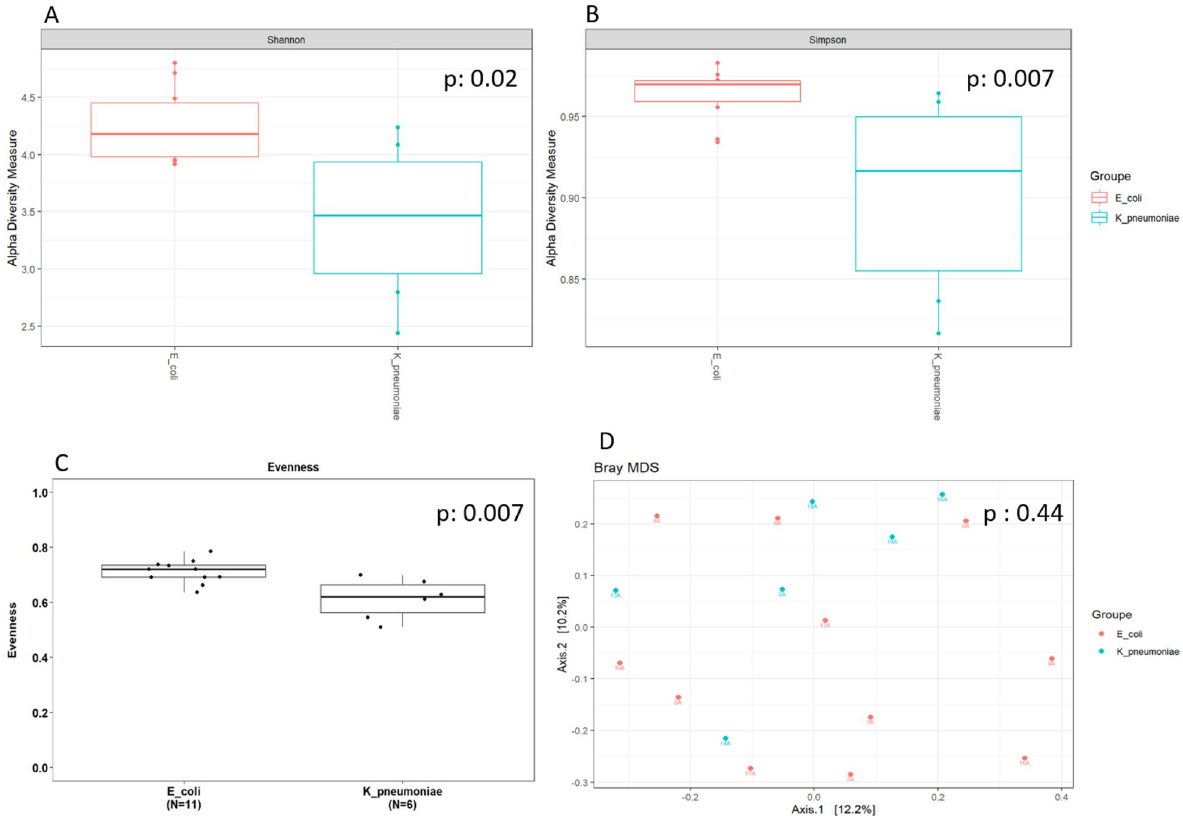
Fig. 2 Comparison of gut bacteriobiota between critically ill ESBL-producing Escherichia coli and Klebsiella pneumoniae faecal carriers. A . Boxplot of estimated α-diversity by Shannon index. B . Boxplot of estimated α-diversity by Simpson index. C . Boxplot of estimated α-diversity by evenness. D . Metric Bray–curtis analysis of β-diversity. red: E. coli , green: K. pneumoniae . Threshold for statistical significance: p